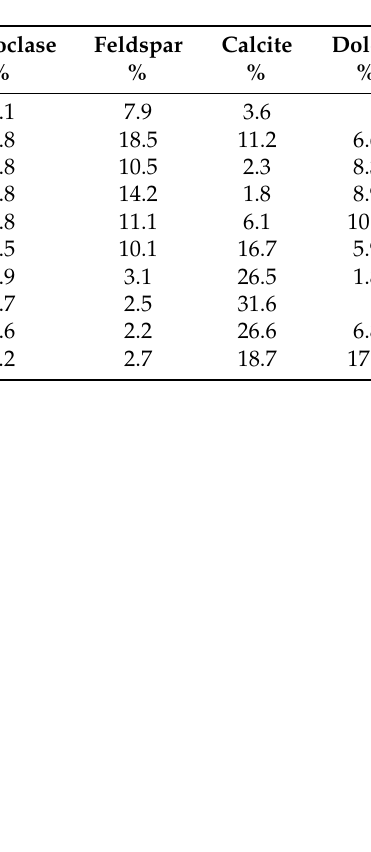
Table 1. Shale TOC contents, mineral compositions, and lithofacies.